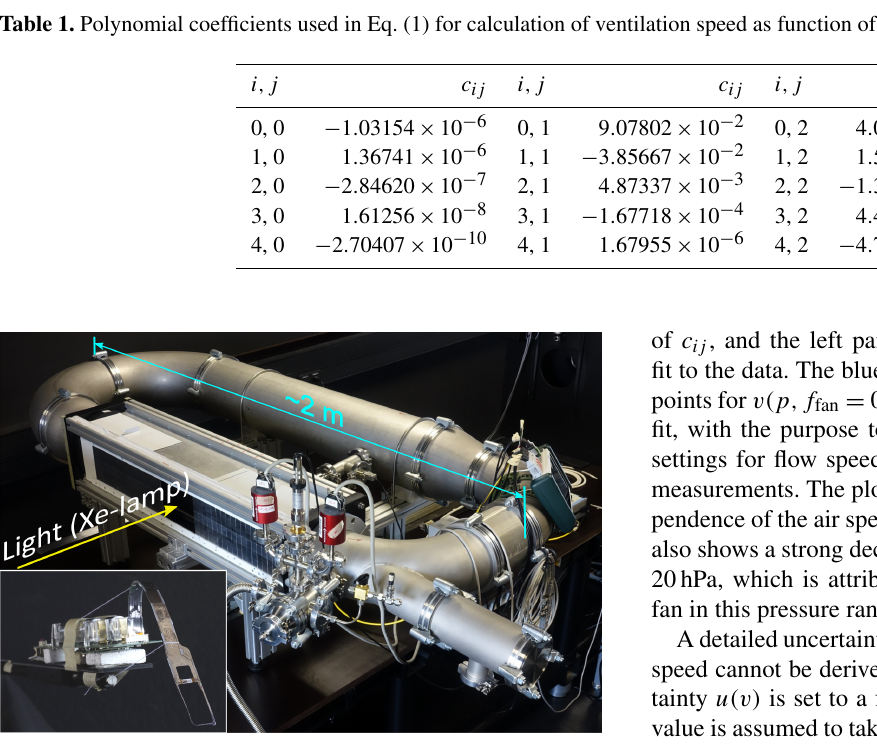
Figure 2. Photograph of SISTER. The inset shows how the ra- diosonde electronic board and sensor boom are mounted on the sonde